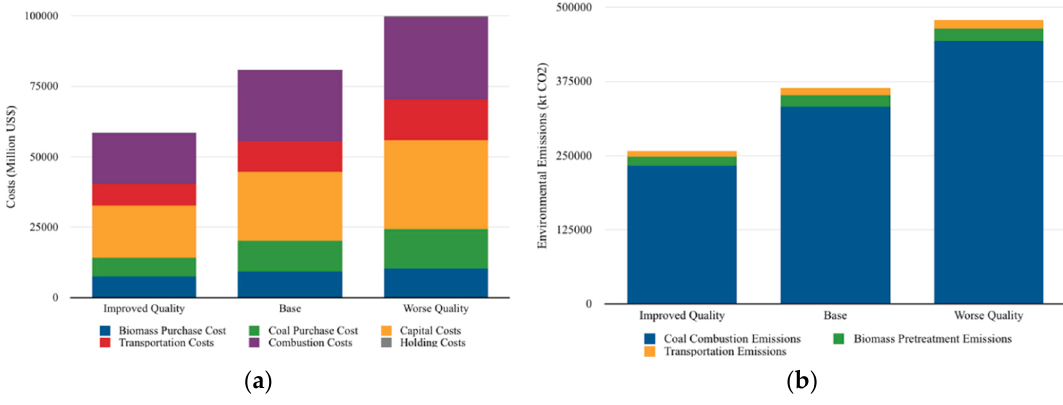
Figure 9. Breakdown of ( a ) costs and ( b ) environmental when Biomass Properties are Varied.